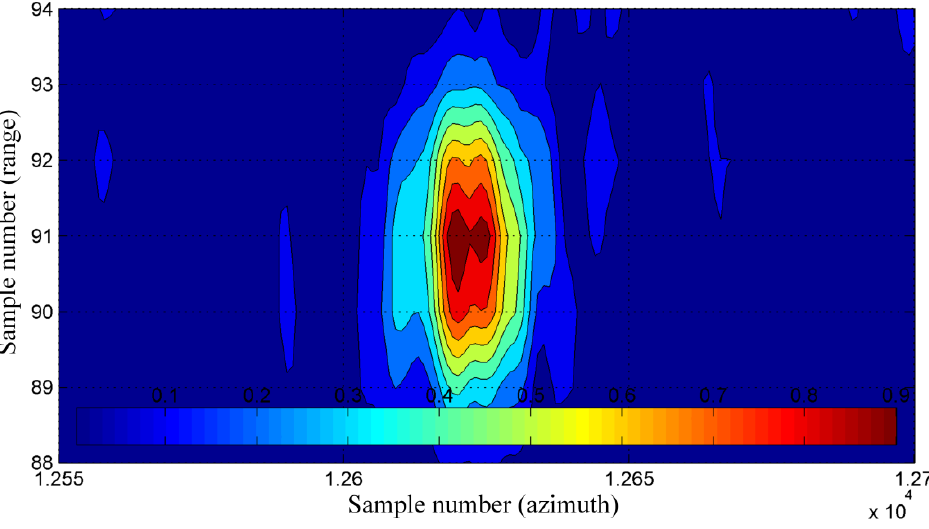
Figure 19. Normalized amplitude of corner reflector with MINS-based MOCO.